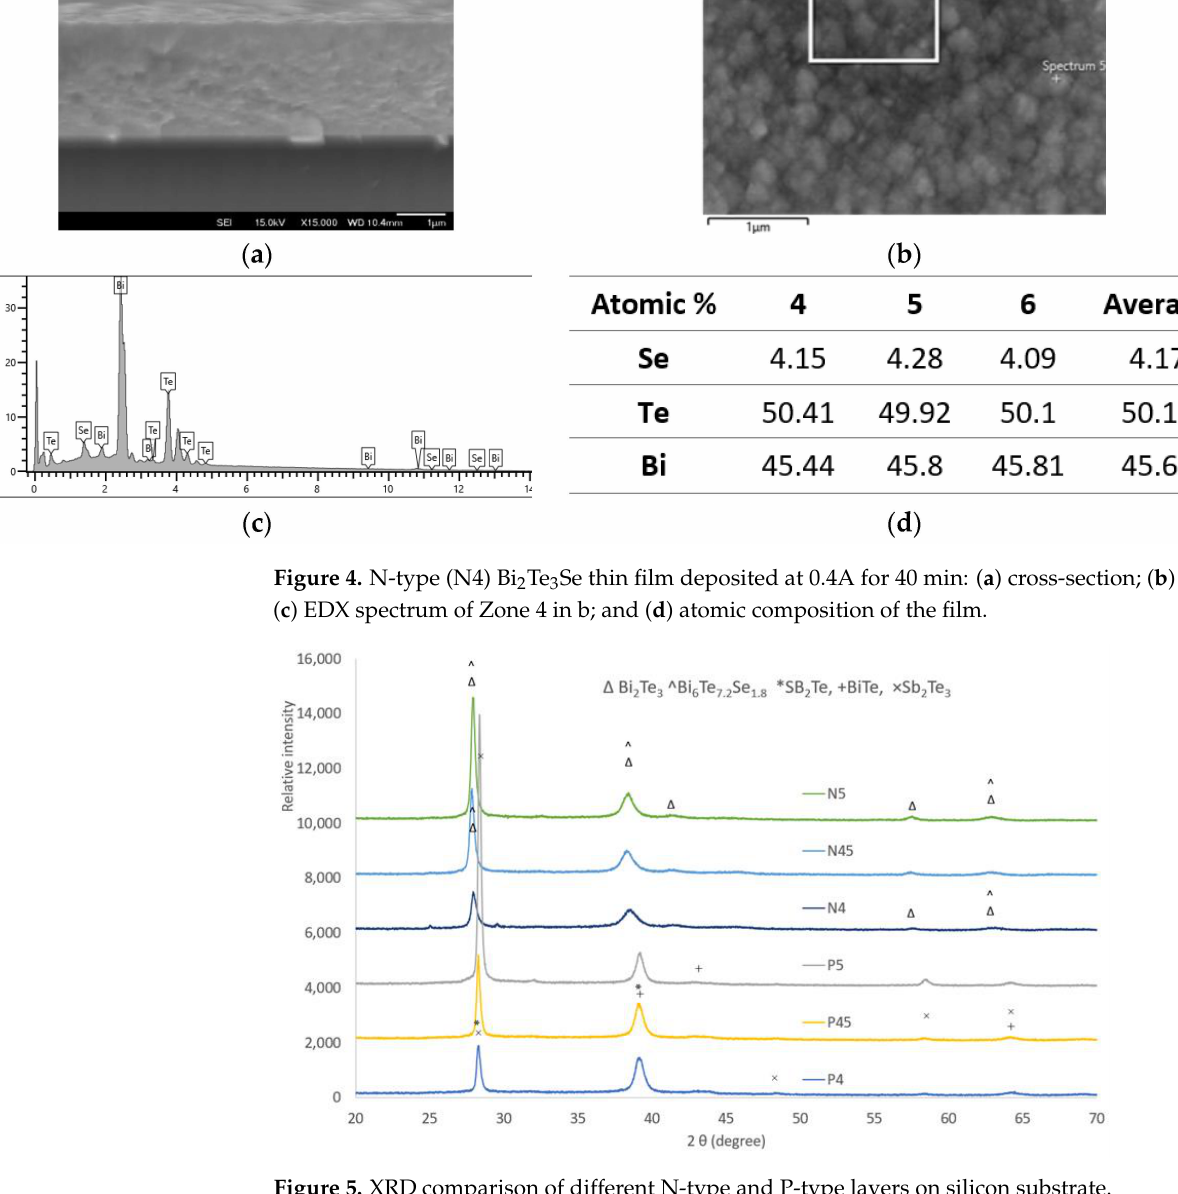
(a) (b) Figure 6. TEM microstructure and corresponding SAD patterns of ( a ) N5 and ( b ) P4. 3.2. Thermoelectrical Properties of the Thin Films Thermoelectric properties measurements of the N-type and P-type thin films within the temperature range from − 150 °C to 230 °C were measured simultaneously in an ad- vanced measurement platform. For all of the thin films, the thermal conductivity increased with the temperature, as shown in Figure 7a. Generally, the N-type layer has a higher thermal conductivity value in comparison with the P-type layer at a lower temperature range (<150 °C ); this might be due to the grain-size effect as the presence of a large number of interfaces (grain bounda- ries), which may effectively scatter phonons while exerting a minimal effect on the transport of charge carriers [7]. In the meantime, the electrical conductivity of the N-type layers is significantly higher than those of the P-type layer, and it decreased slightly with the temperature increment from − 150 °C to about 50 °C and then increased again till the end of the test (Figure 7b).